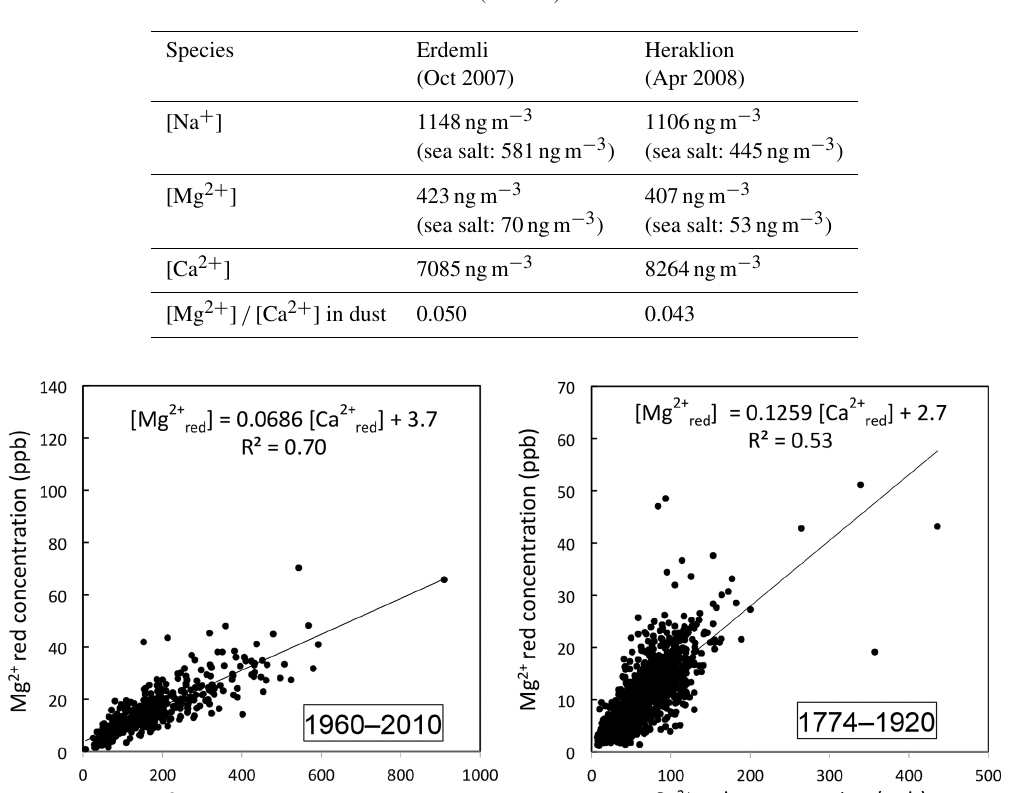
Table 2. Composition of aerosol collected at Erdemli during dust events from the Middle East and at Heraklion during dust events from the Sahara (from Koçak et al., 2012). The magnesium sea-salt contributions were calculated via the Na + content after subtracting its dust contribution, which was calculated as 0.08 times the Ca 2 + content (see text).